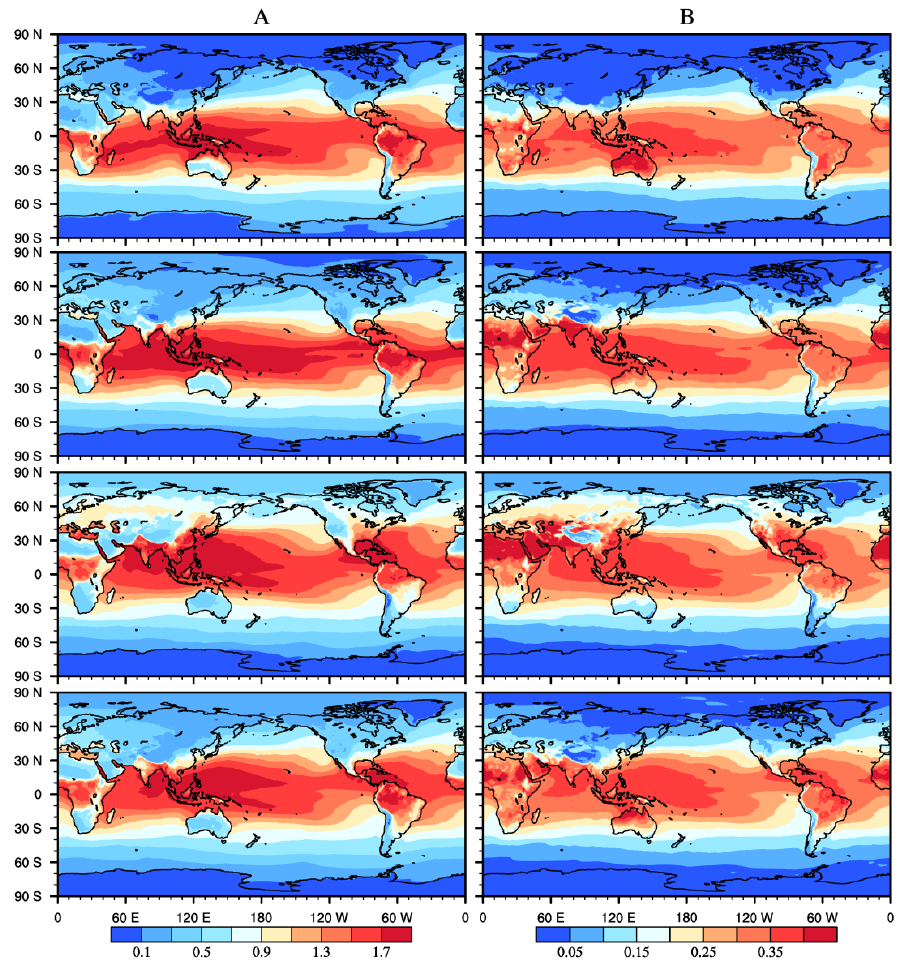
Figure 4. Distributions of the coefficients A ( left ; hPa/K) and B ( right ; hPa/%) obtained with the linear regression. The rows from top to bottom are correspond to January, April, July, and October respectively.